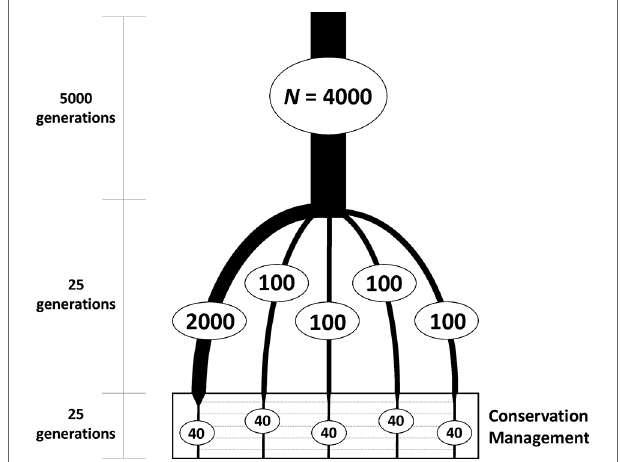
FIGURE 1 | Scheme of the evolutionary history of the simulated subdivided population to be used as a base for a conservation program. One ancestral population of large size ( N = 4,000 diploid individuals) was first maintained for a long period of time to reach mutation-drift equilibrium. From this ancestral population, five subpopulations (with constant population sizes as shown in the figure) were founded and maintained independently for 25 generations. These subpopulations were thereafter maintained with 40 individuals each and subjected to a conservation program aimed at maximizing either expected heterozygosity or allelic diversity of neutral markers, with some migration allowed between